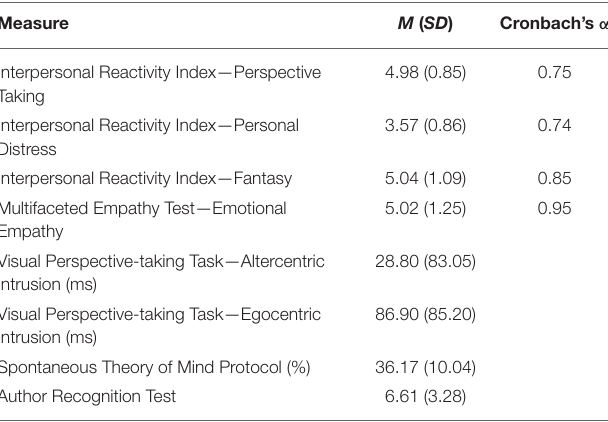
TABLE 2 | Descriptive statistics for measures of social-cognitive abilities and reading-related individual differences.